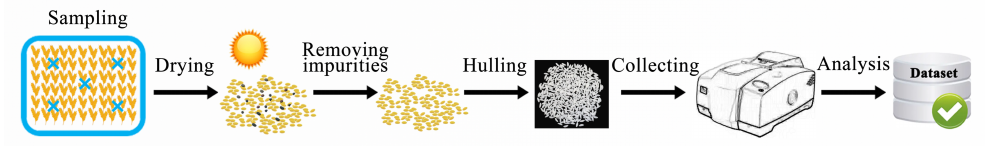
Figure 2. The flow chart of data